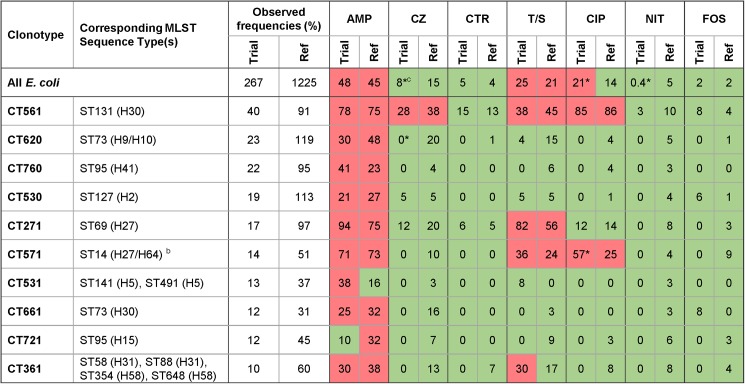
Comparison of antibiotic resistance prevalence among study vs. local reference Escherichia coli isolates for the 10 most frequent study clonotypes.a For each CT (clonotype) the most prevalent (≥ 90% of isolates) sequence type (ST), as determined by multilocus sequence typing, is shown, with its subclone determined by CH typing (H) in parentheses, where applicable. For CTs represented by multiple STs (each accounting for ≤ 90% of the constituent isolates) up to four major STs and the corresponding H subclones are listed. b CT571 comprises ST14 (H27), ST404 (H27) and ST1193 (H64), which all belong to clonal complex of ST14. c For the study set and local reference set (‘Ref’), antibiotic resistance prevalence for all E. coli and for major clonotypes is given as percent of resistant isolates in relation to the total number of isolates, overall or within the clonotype; green color indicates resistance below conventional threshold (≤ 20%), red color–above it (> 20%); the resistance within study and reference sets was compared individually for each antibiotic using a two-sided Fisher’s exact test; * P < .05.